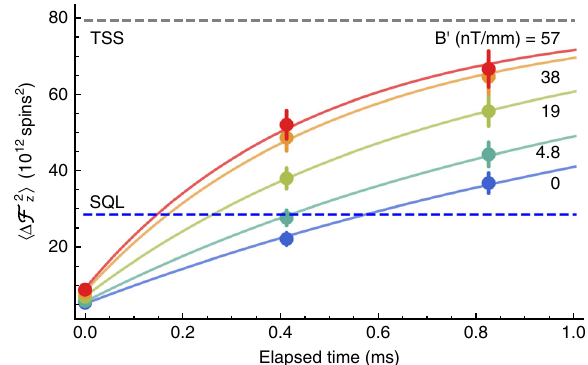
Fig. 3 Evidence for long-range entanglement. Points show the KF-obtained (cid:5) (cid:6) variances Δ F 2 of the rotating-frame spin component F z as a function of z delay since F was last aligned along the laboratory z axis, and thus subject z to measurement by Faraday rotation. Error bars show ±4 σ uncertainty, originating in the uncertainty of atom number. As seen in these data, increased gradient B 0 causes a faster relaxation toward the thermal spin state (TSS) value, as is expected for a gas of singlets with a range of separations (along the z axis) in the mm range. The blue and gray dashed lines are the standard quantum limit (SQL) (2.88(7) × 10 13 spins 2 ) and